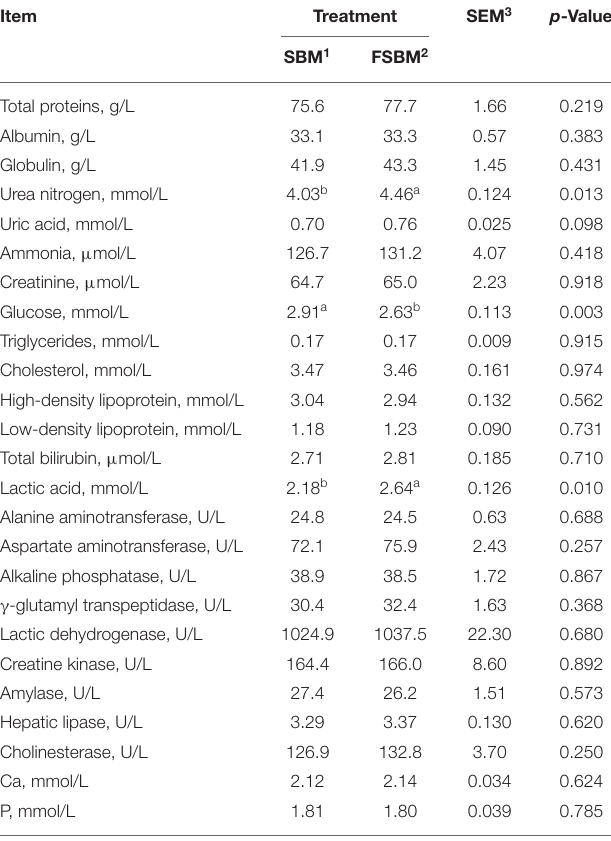
TABLE 3 | Comparison of specific biochemical blood parameters between the SBM group and FSBM